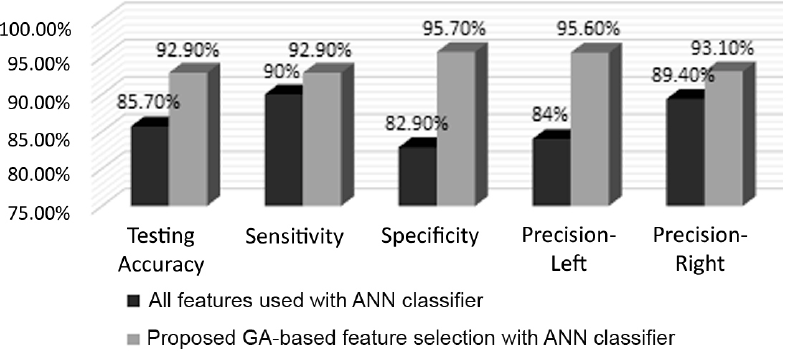
Figure 7. Comparison of ANN classifier performance with and without GA-based feature selection. ANN: artificial neural network. GA: genetic algorithm.